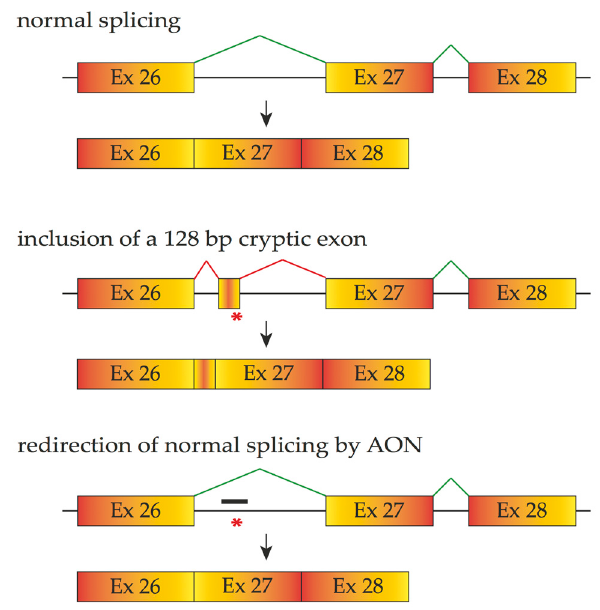
Figure 4. The schematic demonstrates how an intronic mutation (asterisk) that creates a donor splice site results in the inclusion of a 128 cryptic exon in the CEP290 mRNA. Antisense oligonucleotides designed to mask this cryptic splice site (thick black line) prevent recognition of the cryptic exon by the splicing machinery and restores normal splicing products. Boxes represent exons and lines represent introns, red lines and asterisks represent aberrant splicing and